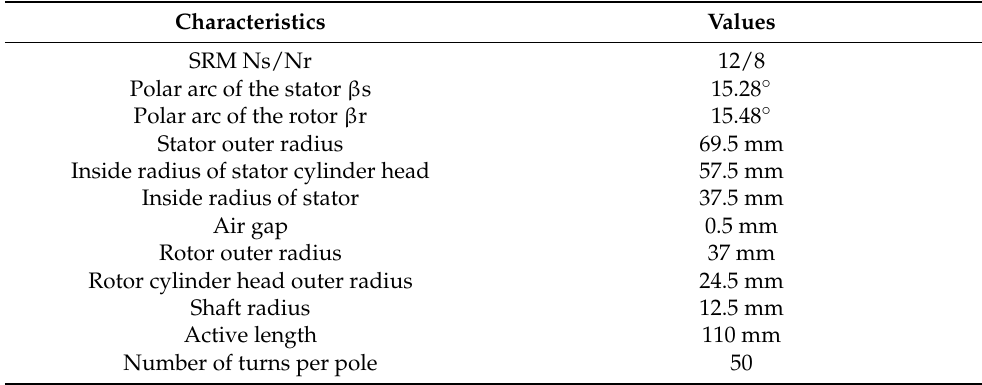
Table 1. Switched reluctance motor characteristics.